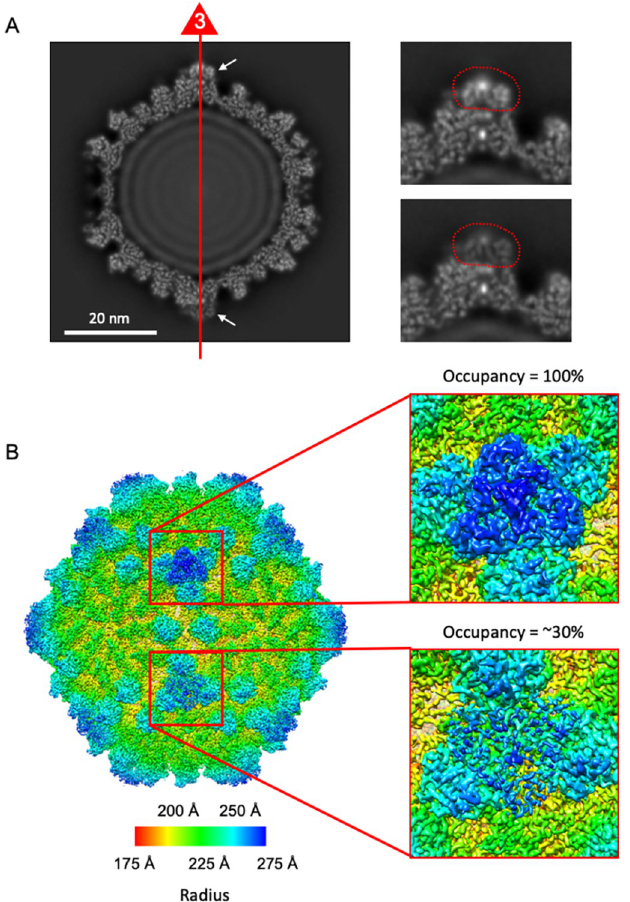
Fig 6. Reconstructed cryo-EM map after 3D focused classification on CrP trimers. A) Overall central cross-section of the RnMBV1 cryo-EM map viewed along the icosahedral 3-fold axis (left panel). Enlarged views of the CrPs (right panels). The CrP trimer is surrounded by a red dotted line. The map intensity level in one CrP trimer (lower right panel) is weaker than that in the other regions, while the map intensity in another CrP trimer (upper right panel) is as strong as that in the other regions. B) Surface representation of reconstructed cryo-EM map. The intensity level in one CrP trimer is recovered as high after the 3D focused classification, which is deemed to be 100% occupancy (right upper panel). The map intensity in the other CrP trimers is low, which corresponds to approximately 30% occupancy (right bottom panel). The image is colored radially according to the distance from particle center. located at the 5-fold axes [8,10,55–57], however, 2/3-fold pores have also been proposed in RnQV1 and victorivirus [40,58]. Hence, for Megabirnaviridae viruses, the pores are also expected to exist; however, the 5-fold pore is obstructed in the RnMBV1 capsid (Fig 8A and 8B). Positively charged residues Arg140 and Arg141 conformationally block the pore and con- tribute to positive surface charges (Fig 8B and 8C). A positively charged cluster can enhance the NTPs uptake, as described previously for HIV [59] and dsRNA toti-like viruses [8]. The C- terminal arm (Val1198–Gln1203) of each MCP_B subunit also contributes to the pore config- urations interiorly (Fig 8D), which is unique for the Megabirnaviridae RnMBV1 capsid. The exterior and interior sides of the pore become obstructed/narrower because of the Arg residue obstructions and the C-terminal arms; however, the pore still seems to retain approximately 1 nm, on average, to enable release of their synthesized ssRNA gene (Fig 8E).